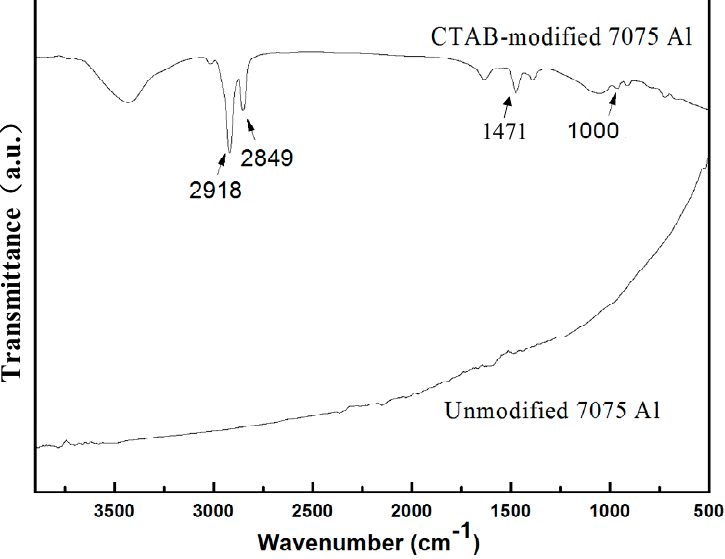
Figure 4. FTIR spectrum of unmodified and CTAB-modified 7075 Al powders.